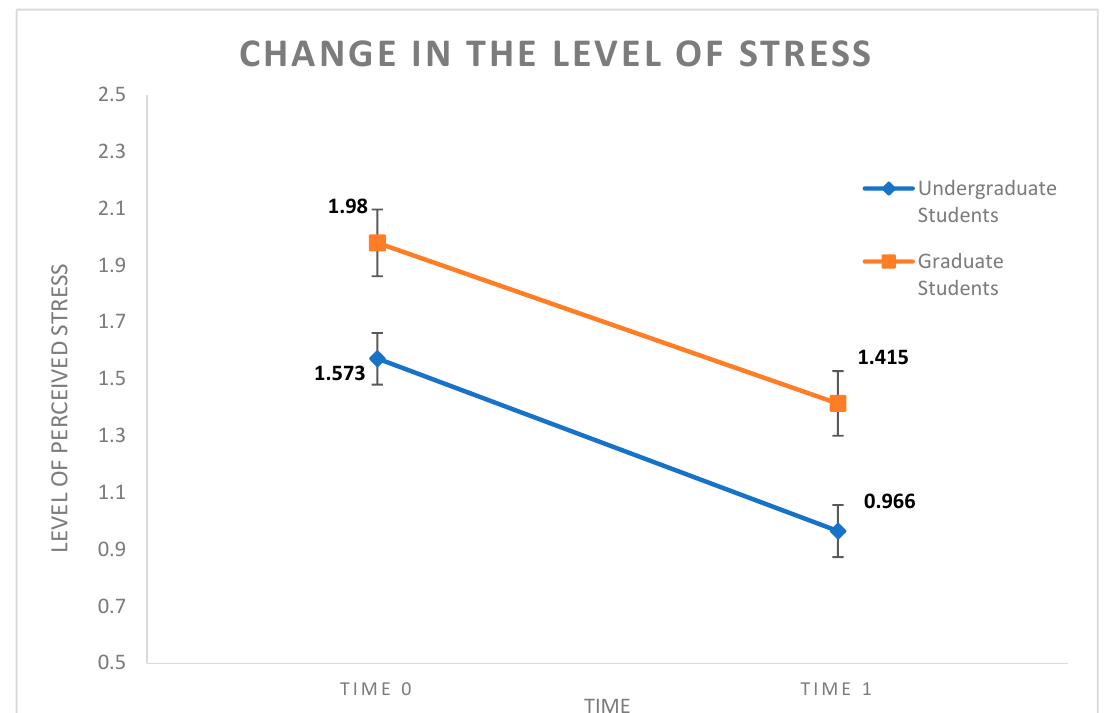
Figure 1. Changes in the level of perceived stress in participants from undergraduate students and graduate students.